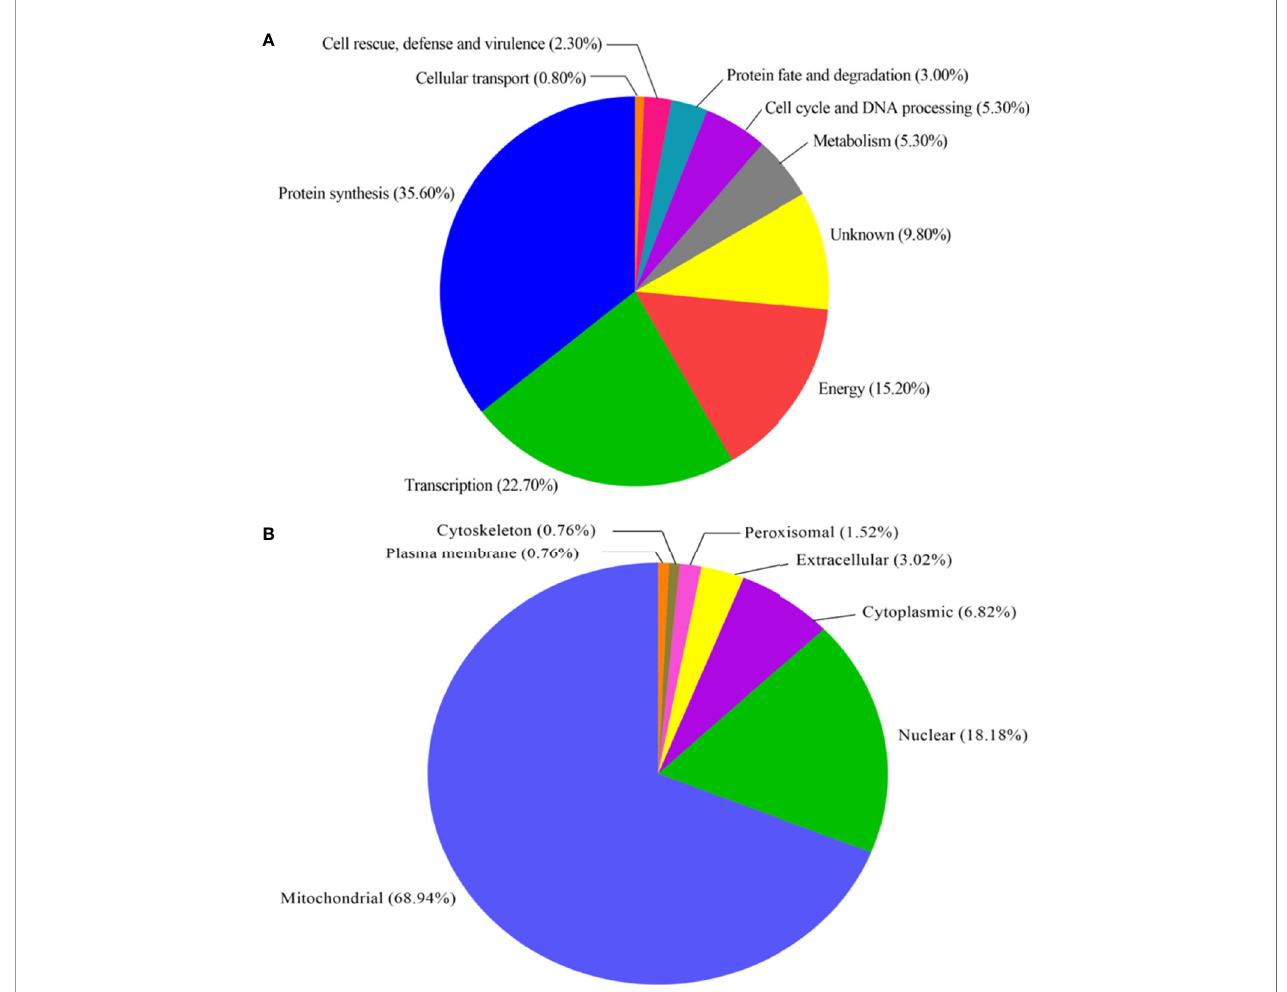
FIGURE 3 | Functional classi fi cation and subcellular localization of immunoreactive proteins identi fi ed in Histoplasma capsulatum . (A) Functional classi fi cation of proteins based on UniProt database; (B) Subcellular localization of proteins based on the WoLF PSORT